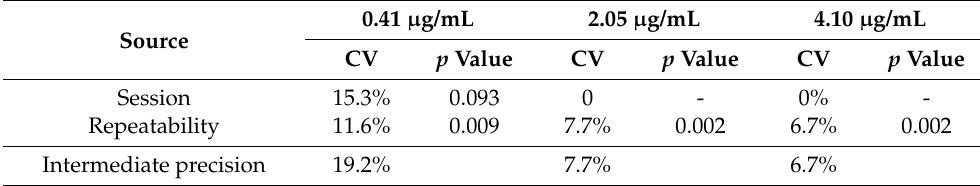
Table 1. Variance component analysis for reproducibility of Dische colorimetric